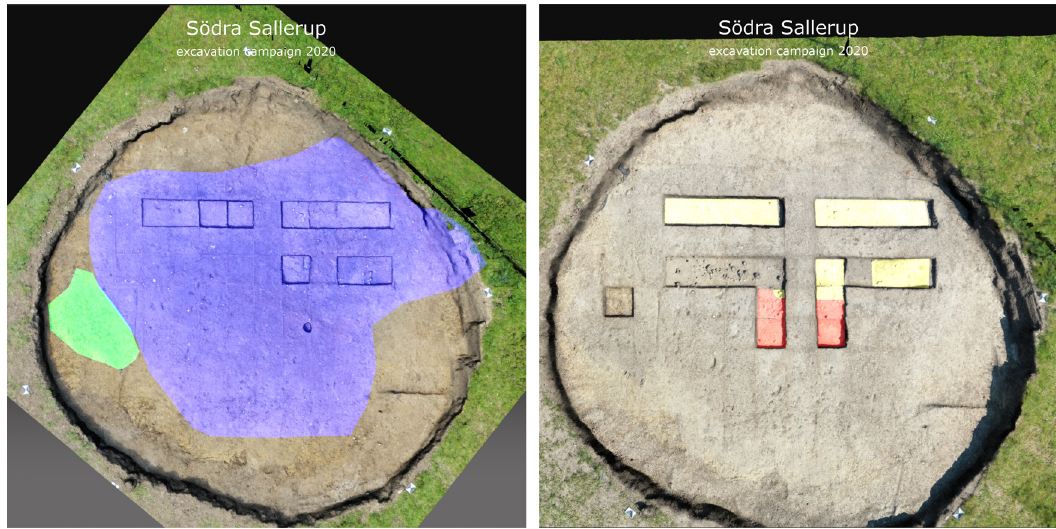
Figure 7: The IVS displays, on the left, contexts 101 and 103 at the beginning of the excavation; on the right, contexts 102 and 104 at the end of the excavation investigation. Illustration: Paola